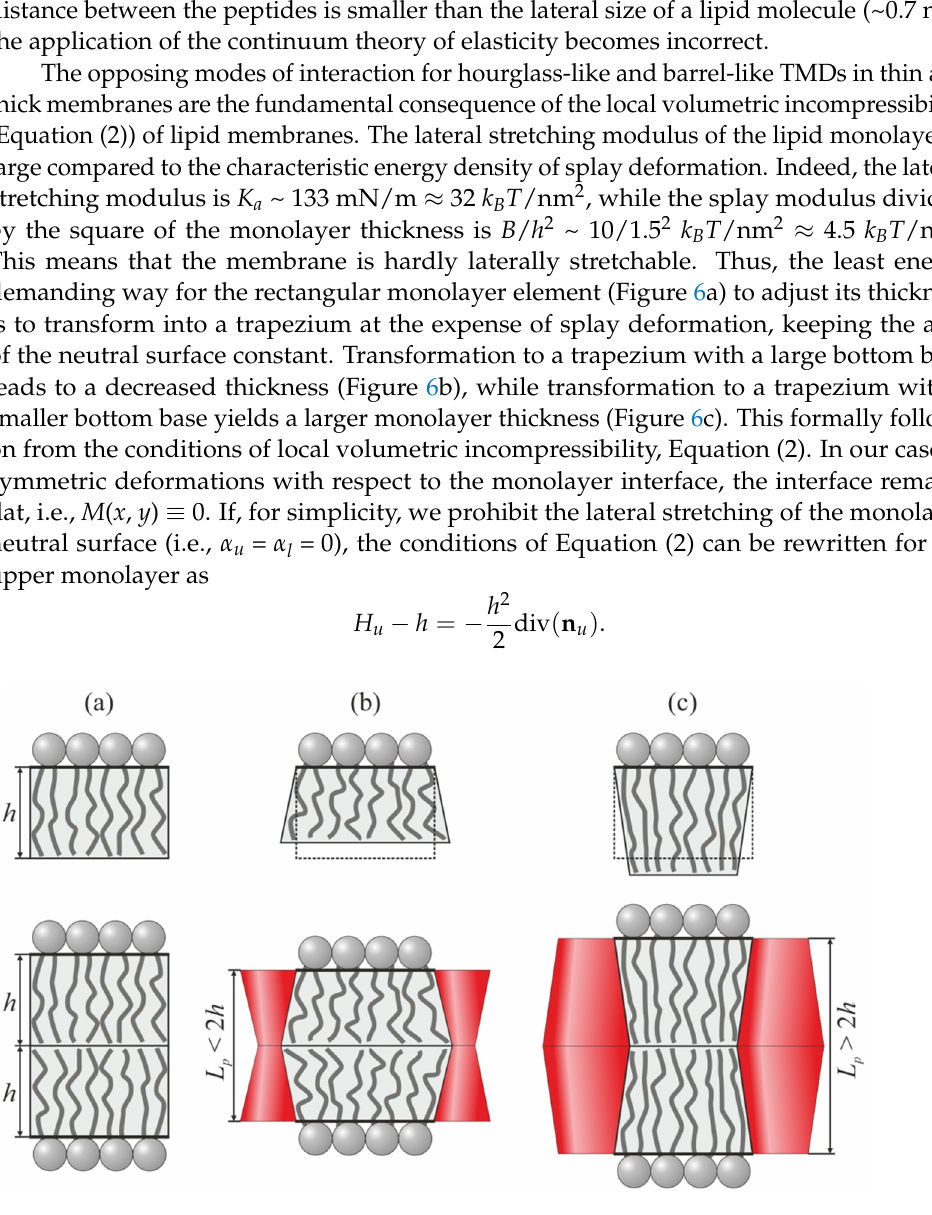
Figure 6. The local volumetric incompressibility allows the monolayer element thickness to be matched to half of the TMD length via transformation of the rectangular element ( a ) to a trapezium- like shape with either: ( b ) a larger bottom base (decreased thickness) or ( c ) a smaller bottom base (increased thickness). The former trapezium fits in better between the hourglass-like TMDs, the length of which is less than the bilayer thickness ( b ), while the latter trapezium fits in better between the barrel-like TMDs, the length of which is greater than the bilayer thickness ( c ).